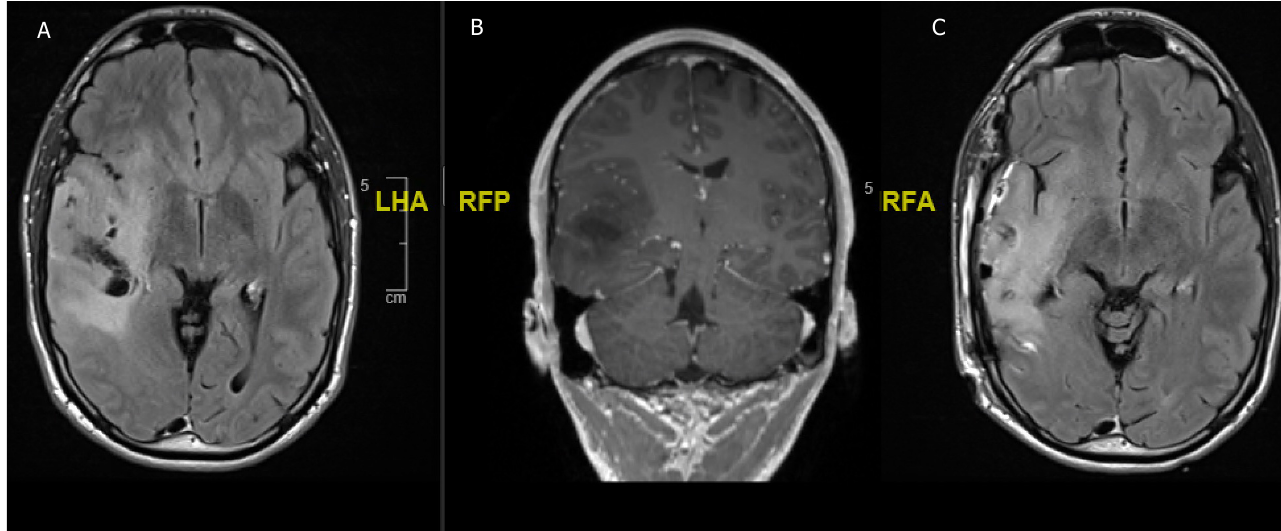
Figure 1. A 21-year-old male, presenting with a generalized seizure. ( A ) Flair hyperintense fronto-temporal tumor of 8.6 × 4.5 × 5 cm with central hypointensity suggestive of aLGG. ( B ) T1 hypointense tumor surrounded by the vessels of the sylvian fissure. ( C ) Postoperative imaging after awake fronto-temporal craniotomy and partial tumor resection due to language impairment